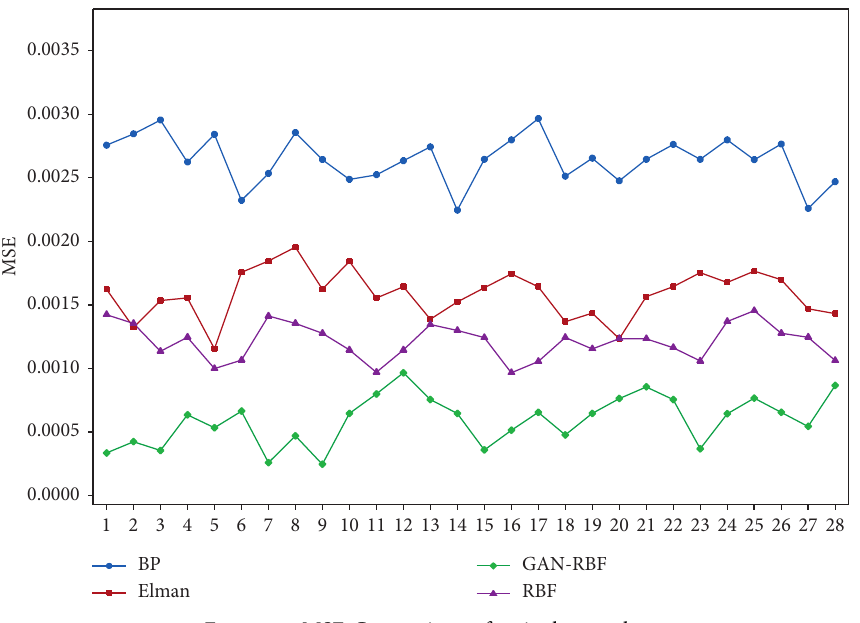
Figure 7: MSE Comparison of a single sample. Table 3: Running times of four